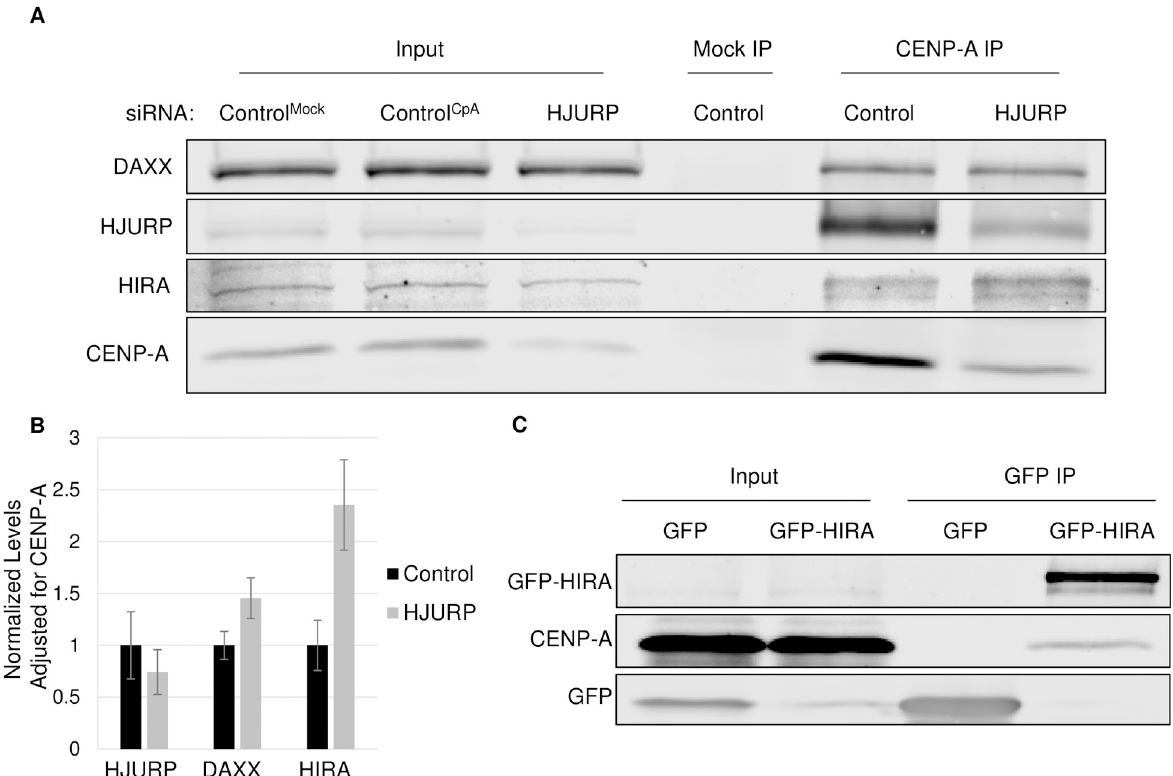
Fig 2. The H3.3 chaperone HIRA binds to endogenous CENP-A. A.) Western blot analysis of IPs using either CENP-A IP (ACA antibody) or Mock IP from soluble pool obtained from SW480 cells that were treated for 72 hours with either control or HJURP siRNA as indicated. Control Mock IP was performed on control siRNA treated cells with no antibody while Control CpA Ip was performed on control siRNA treated cells with the antibody. B.) Graph indicating the levels of each indicated chaperone in the CENP-A IP shown in A. Levels for each chaperone were normalized to control and also the amount of CENP-A pulled down in either control or HJURP siRNA experiments. Results are obtained from triplicate experiments. C.) Western blot results from IP of soluble GFP or